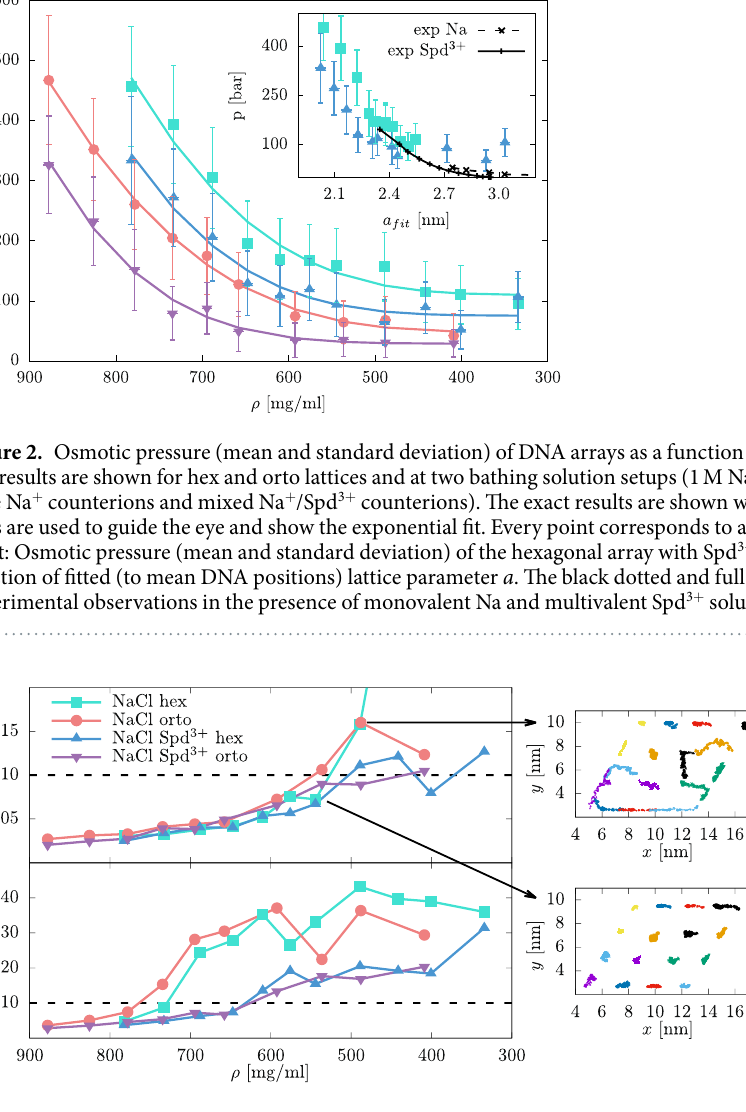
Figure 3. Positional (divided by lattice parameter a ) and rotational (divided by π ) standard deviations of mean values as a function of DNA density for the hex and orto lattice with pure NaCl and mixed NaCl and Spd 3 + counterions. The horizontal dotted lines indicate the typical 0.1 Lindemann threshold value. The insets show the COM of DNA molecules in the xy plane, as monitored during a 20 ns simulation, for the two sizes of the hex lattice with pure NaCl counterions as indicated by the